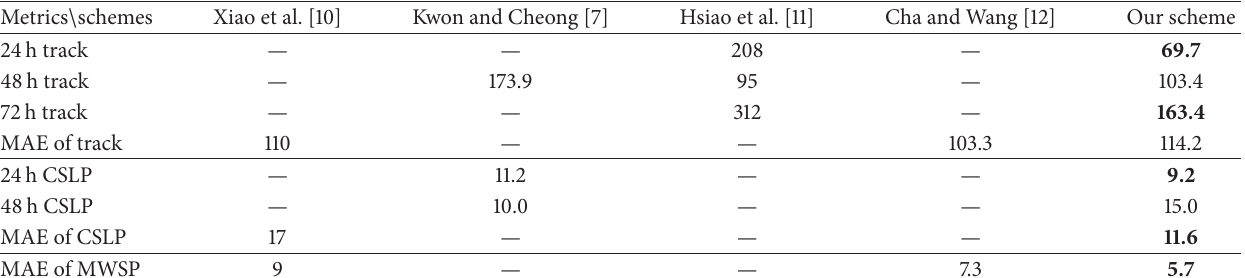
Table 5: Comparisons of our scheme with other schemes.